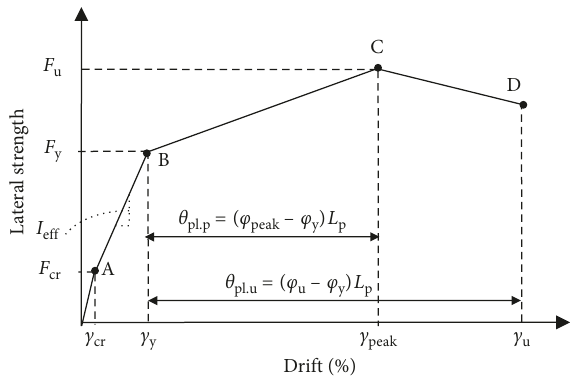
Figure 10: The simplified model of lateral load-drift capacity.